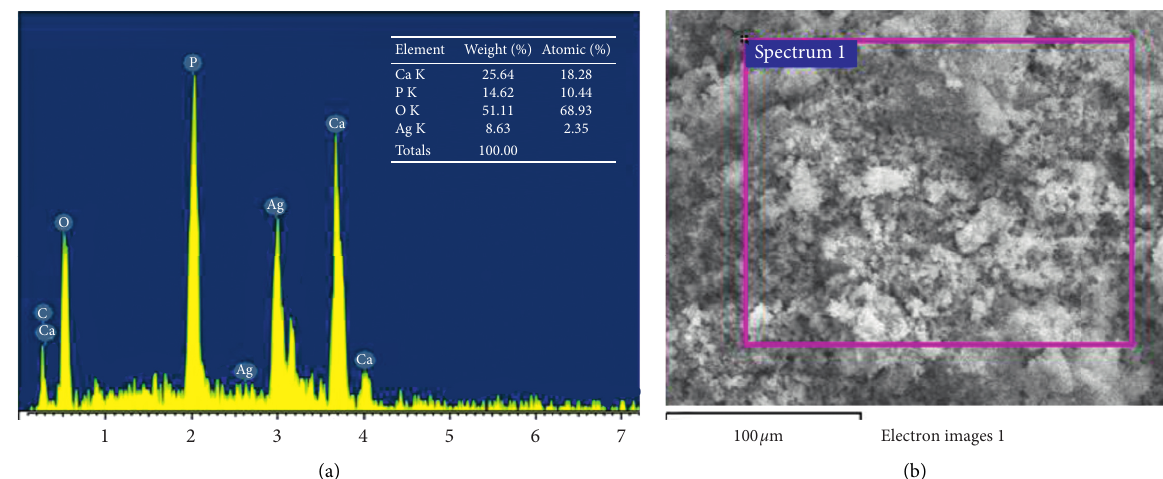
Figure 11: The EDX spectrum of